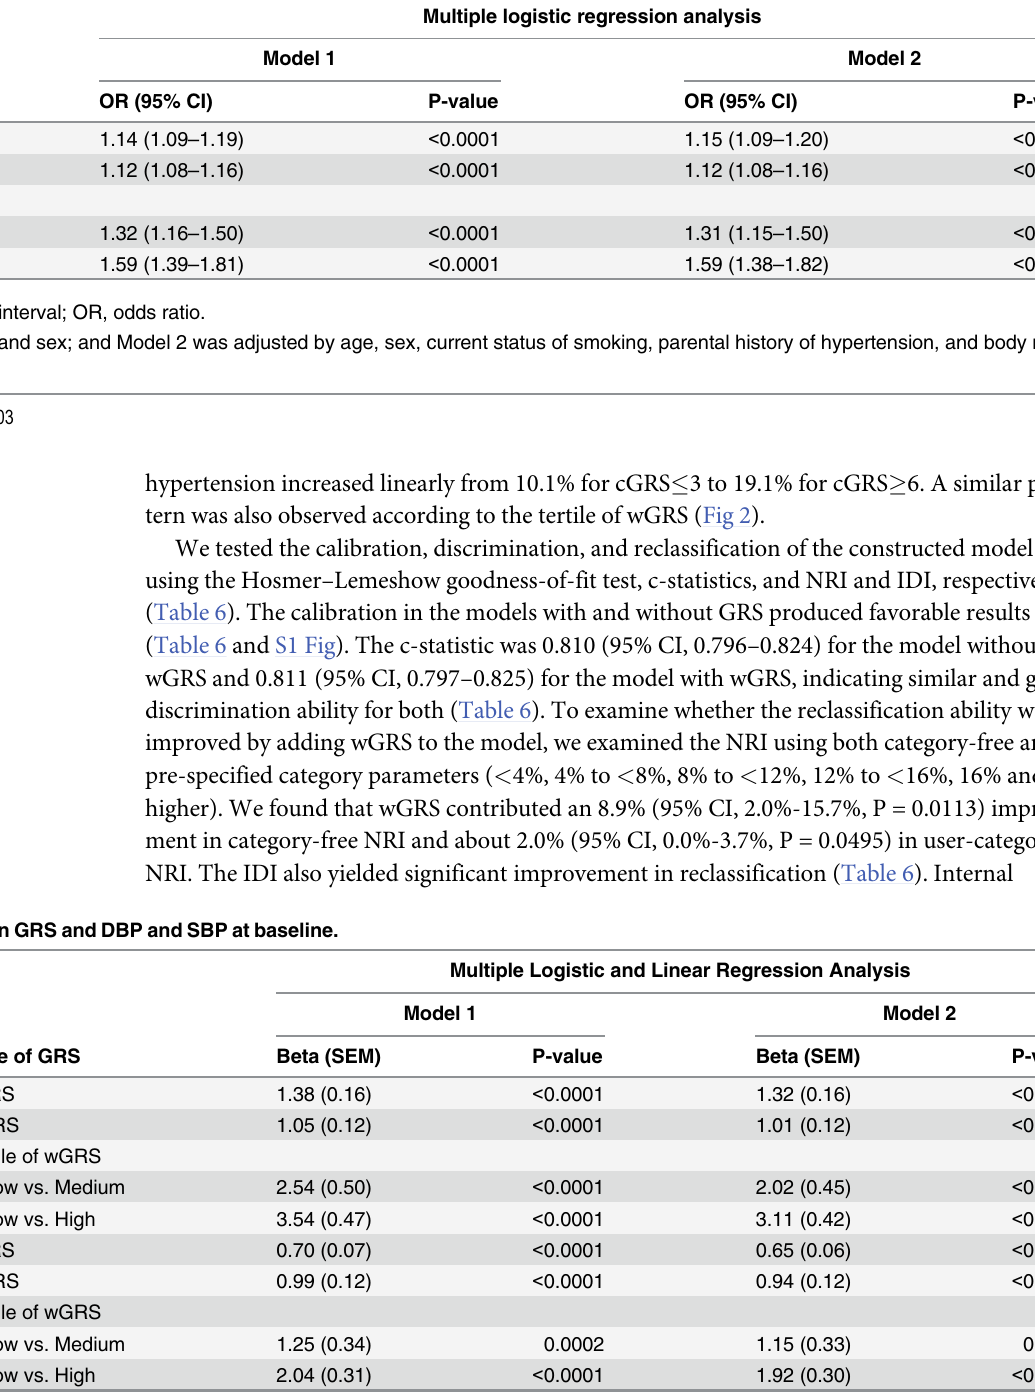
Table 3. Association between GRSs and hypertension for cross-sectional analysis.